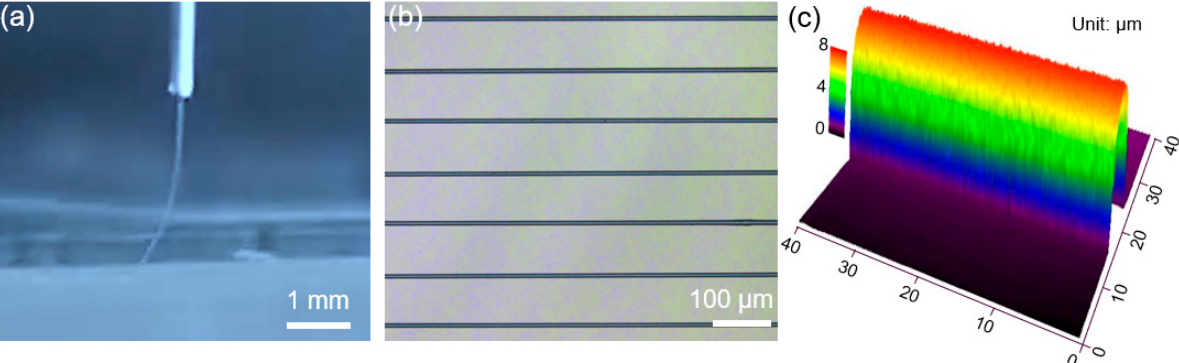
Figure 2. EHD printing of the PVDF fibers. ( a ) The optical image of the ejected fibers from the nozzle, which was obtained by the real-time monitoring system. ( b ) Straight PVDF fibers with the width of 8.3 ± 1.2 μ m, with a fiber spacing of 100 μ m. ( c ) The 3D profile of a single EHD-printed PVDF fiber.